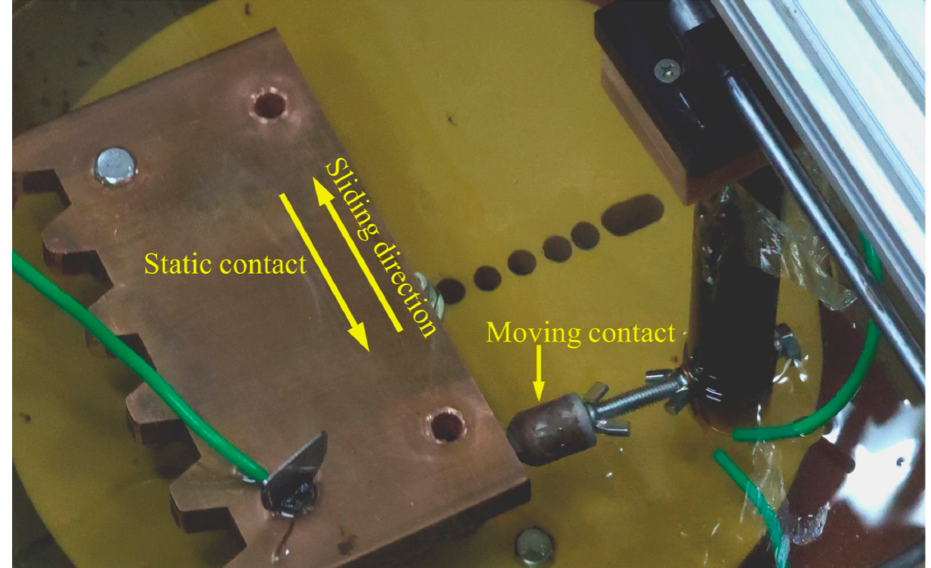
Figure 2. Image of real-life equipment for OLTC experimental test.